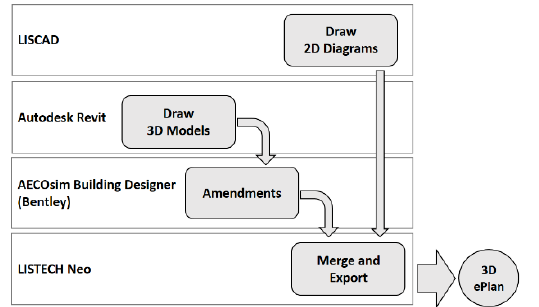
Figure 7. defined steps and utilised software for creating a 3D